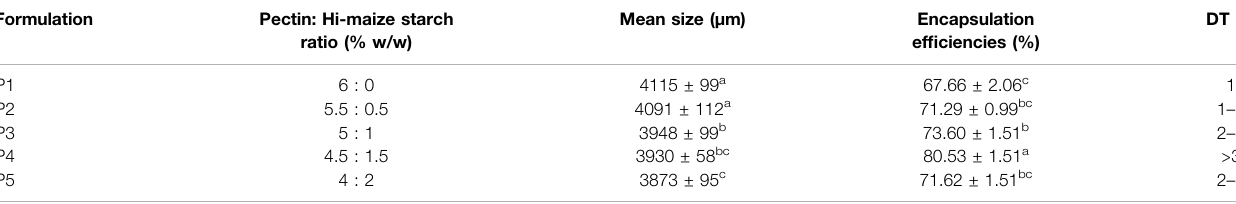
TABLE 1 | Properties of various pectin/hi-maize starch hydrogel beads. Formulation